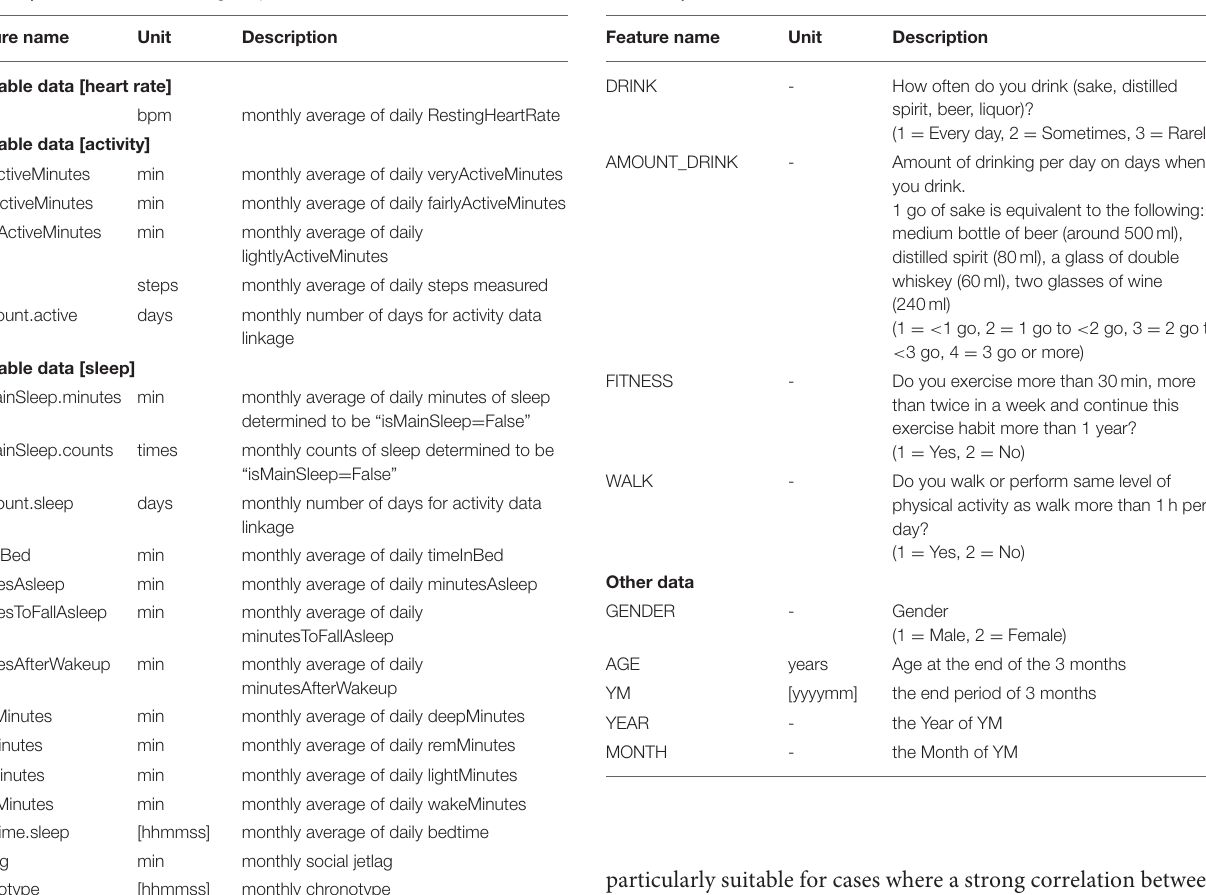
TABLE 1 | Features used in building the predictive